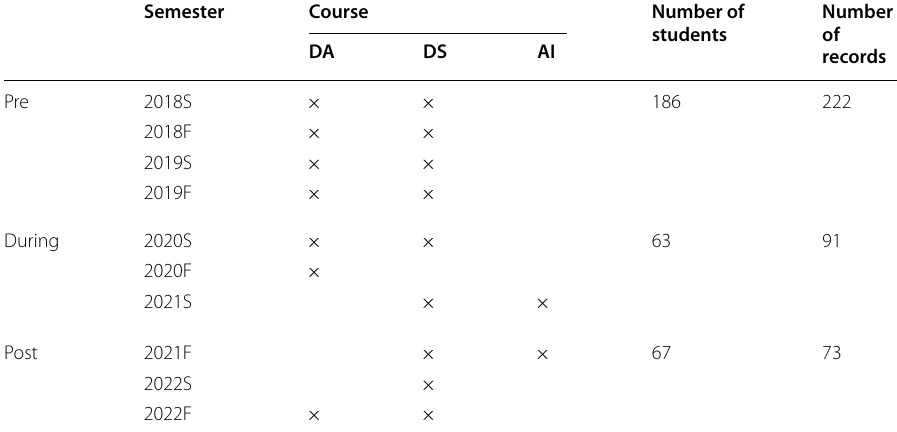
Table 3 Overview of matched data